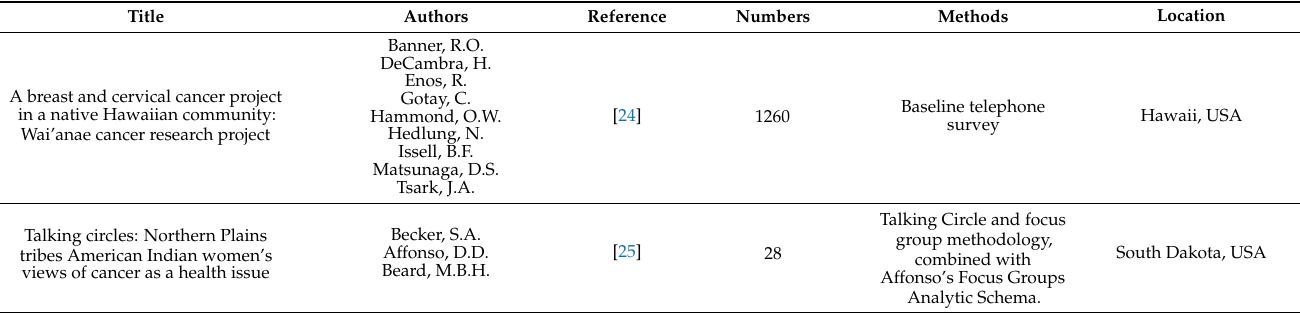
Table 1. Summary of